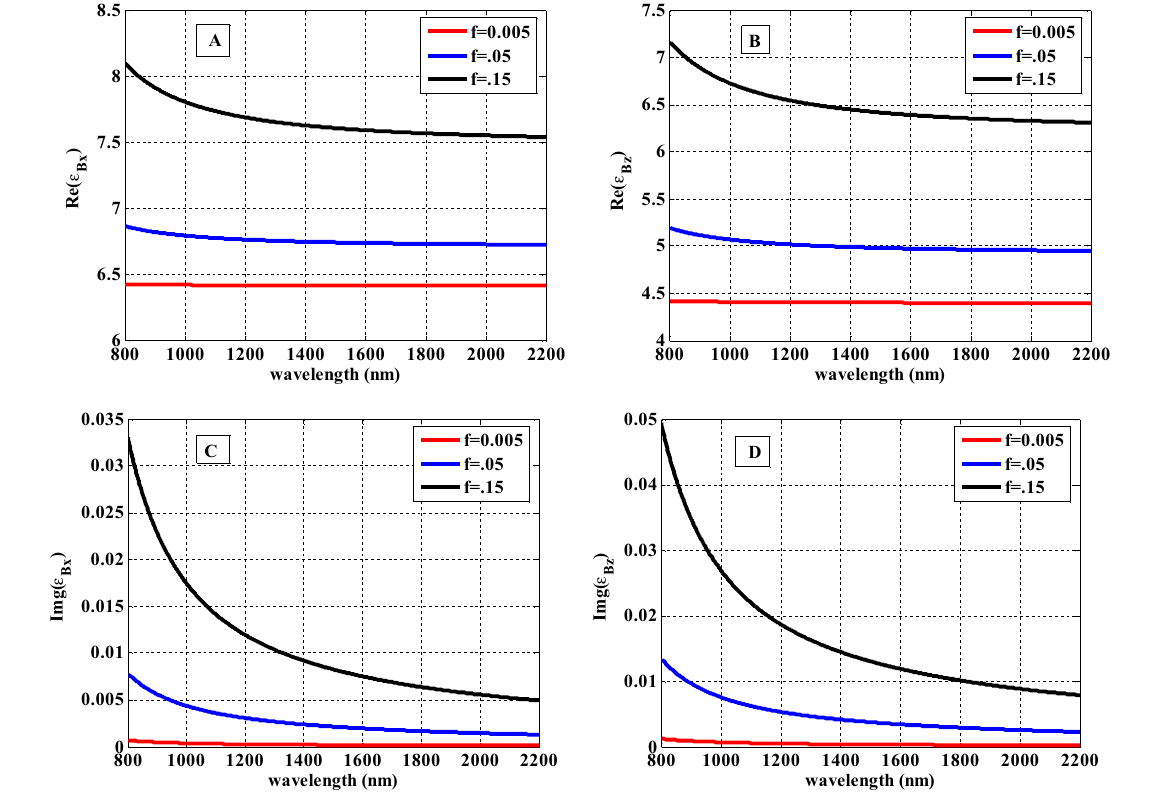
Figure 4. Effective permittivity of HMM (Real and imaginary parts) in the x and z components as a function of